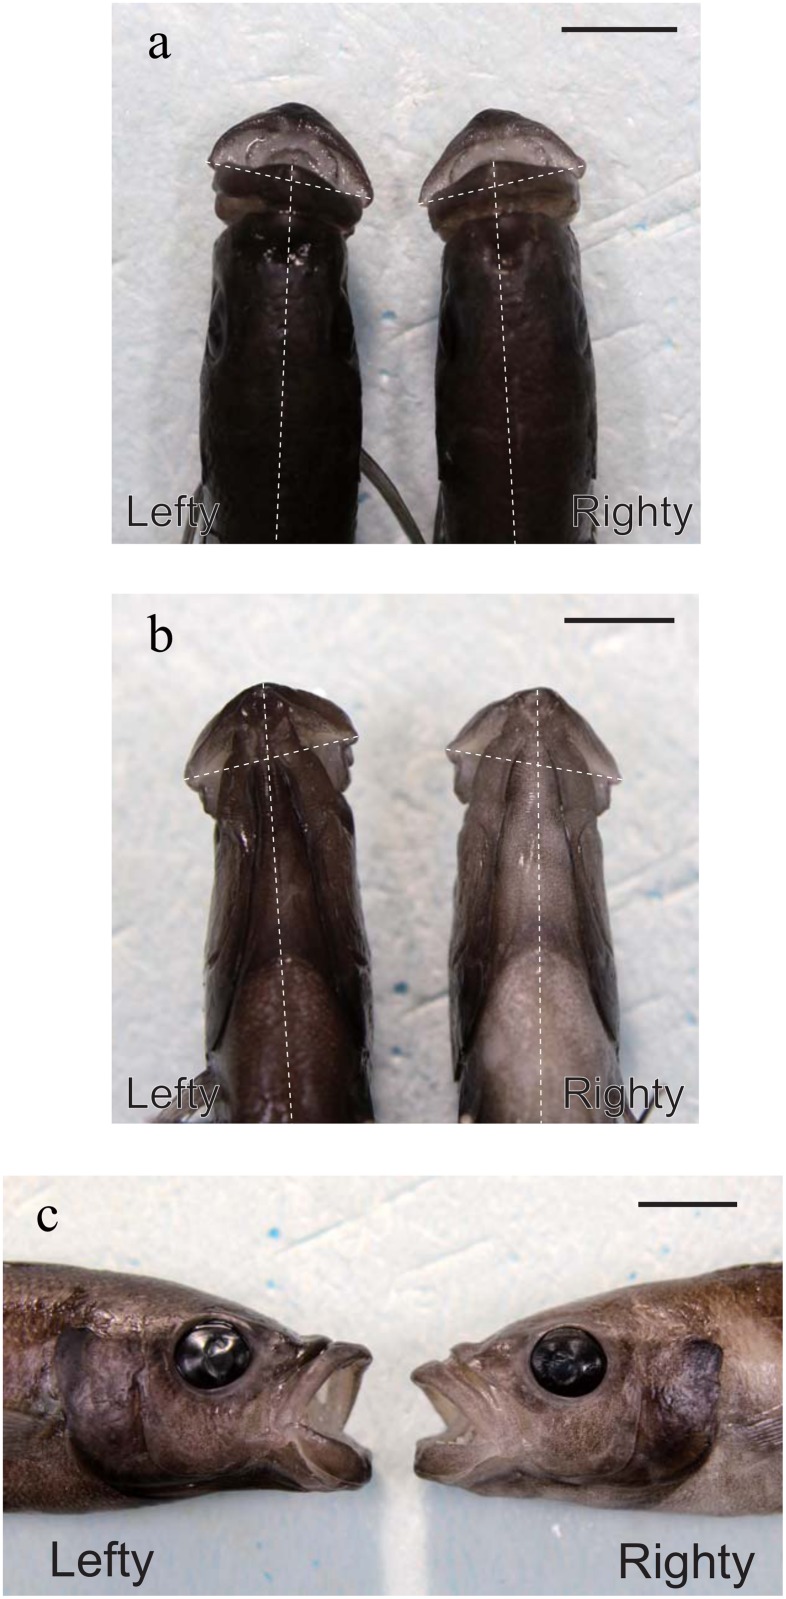
Morphological mouth asymmetry of scale-eating cichlid fish Perissodus microlepis.a, Dorsal view, b, ventral view, c, lateral view of the mouth morphologies of lefty and righty fish in adults. The dotted lines indicate the midline and the lateral tips of the lips. In dorsal and ventral views, the line of the lips in the lefty (righty) clearly leans to the right (left). Scale bar = 1cm.